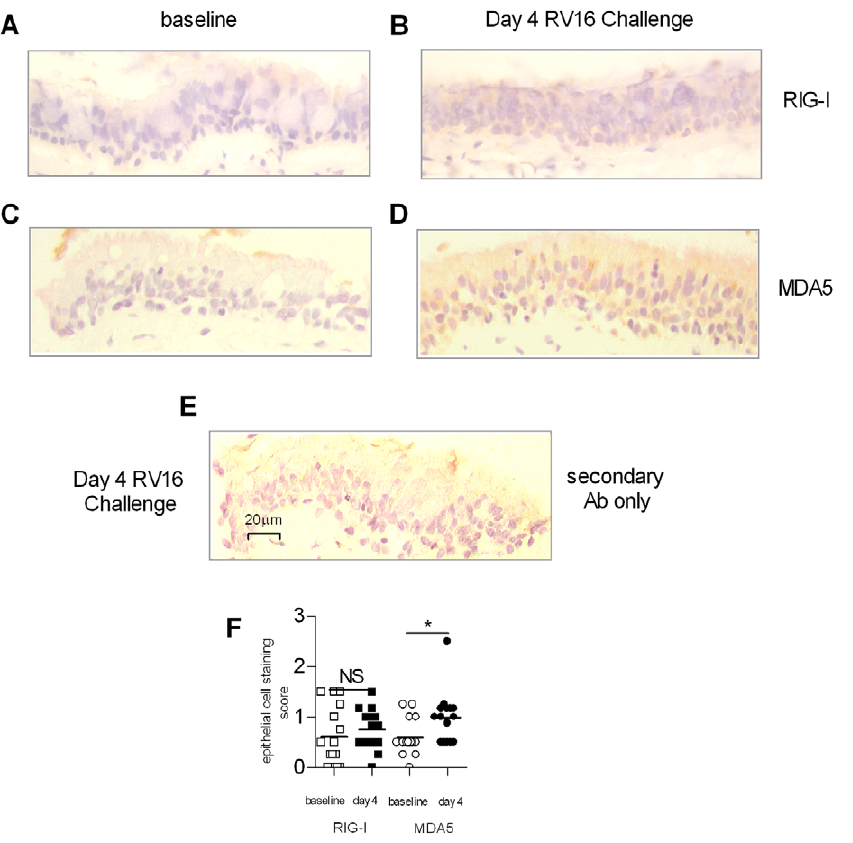
Figure 2. RIG-I and MDA5 expression in bronchial biopsy tissue following invivo RV16 infection. Normal individuals underwent fibre- optic bronchoscopy at baseline or day 4 following RV16 challenge, and bronchial biopsies were taken, and assessed for RIG-I protein by immunohistochemistry at baseline (A) and day 4 post RV16 challenge (B). Biopsies were also assessed for MDA5 protein at baseline (C) and day 4 post RV16 challenge (D). Positive staining is indicated by the brown coloration, localized to the columnar epithelial cells. Background staining was assessed by incubating a Day 4 biopsy with secondary antibody only (E). Staining scores of bronchial epithelium showing increases at day 4 compared to baseline (F) * p , 0.05 as indicated, NS = not significant. Scale is indicated by the horizontal